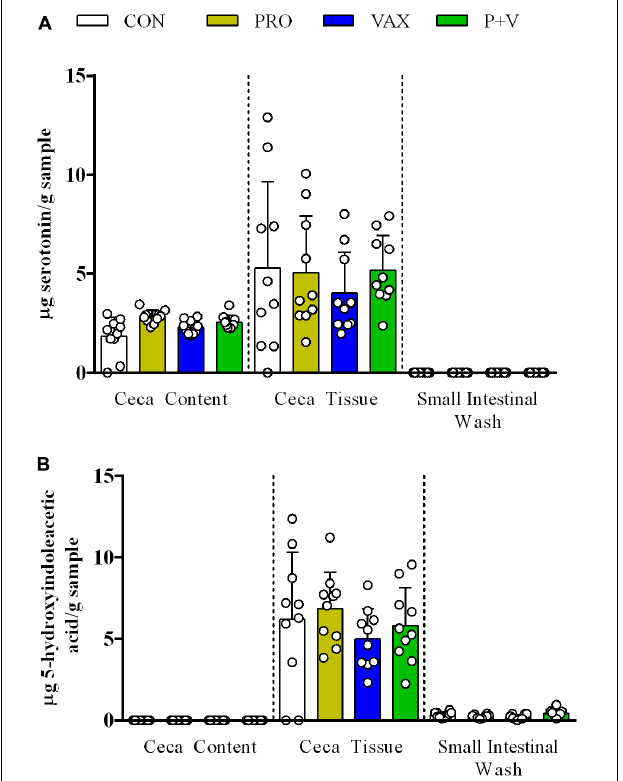
FIGURE 2 | Detection of serotoninergic metabolites (A) serotonin and (B) 5-HIAA acid in ceca content, ceca tissue, and small intestinal scrapings. Each dot represents an individual animal, bars represent mean ± standard deviation. White, CON; yellow, PRO; blue, VAX; green, P+V.